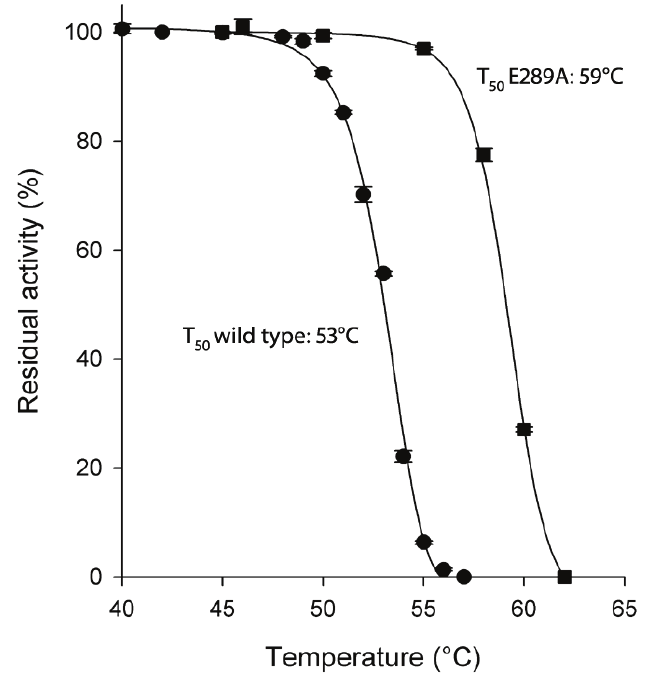
Figure 2. Thermostability of HpASNase E289A mutant compared to wild type enzyme. Plot of the residual activities at 10 min heat-treatment vs. temperatures. Incubation buffer was 20 mM Na-phosphate pH 7.5. After 10 min incubation at a given temperature, the enzyme sample was chilled and the residual activity measured. T 50 is the incubation temperature at which the enzyme loses 50% of its activity in 10 min. Wild type (cid:5), E289A mutant (cid:6). Data are represented as averages ( n (cid:7) 2) with error bars